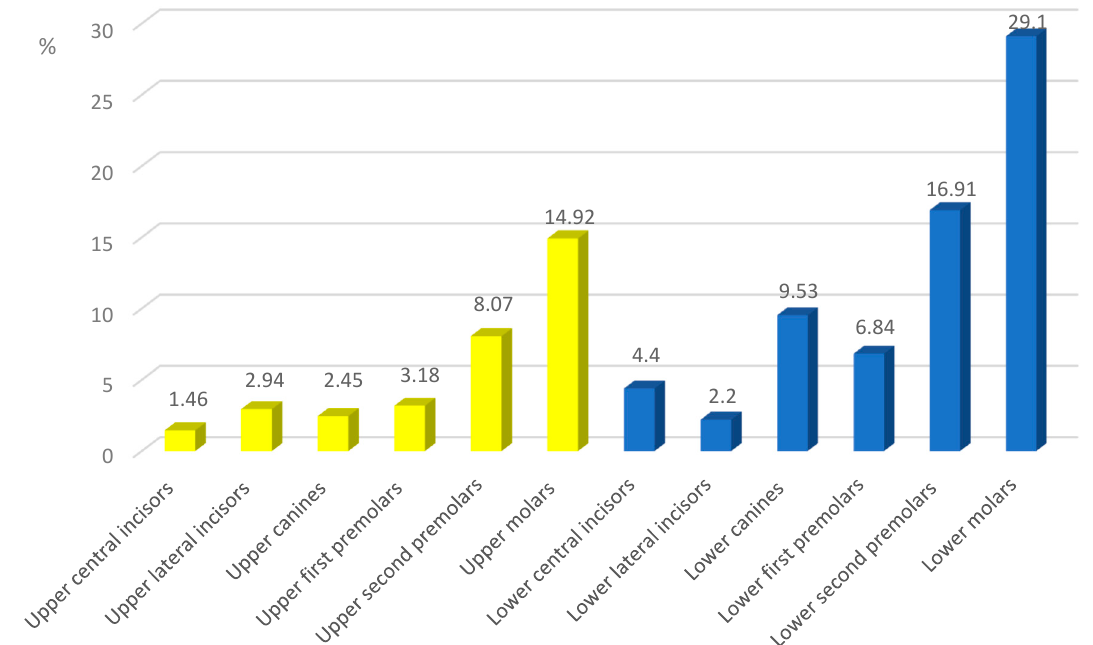
Figure 1. Distribution of brackets failures in different groups of teeth.